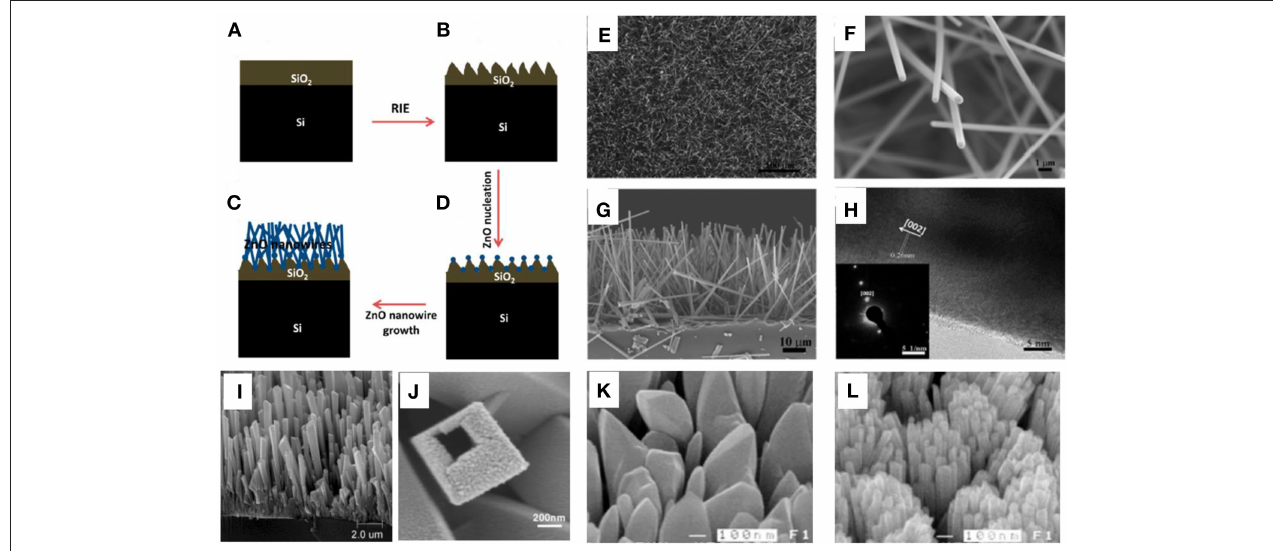
FIGURE 4 | Schematic diagram of the growth process of ZnO nanowire array: (A) the pristine SiO2/Si substrate before etching; (B) Roughened SiO 2 /Si substrate surface with spikes and valleys; (C) ZnO nucleation sites on the RIE etched SiO 2 /Si substrate after etching treatment; (D) ZnO nanowire arrays grown from the ZnO nucleation sites. (E) Top view SEM image of the ZnO nanowires array; (F) Magnified SEM image of ZnO nanowires with clean and hexagonal tips. (G) Side view SEM image of a ZnO nanowire array. (H) HRTEM image of a single ZnO nanowire and the inset figure is the corresponding SAED pattern which indicate the growth direction is [001]. Reprinted with permission from Xu et al. (2015), copyright 2015 American Chemical Society. Microscopic figures of SnO2 tubes synthesized at 1,150 ◦ C: (I) cross-sectional view; (J) a single tube with partially opened top end. Reprinted with permission from Liu and Liu (2005), copyright 2005